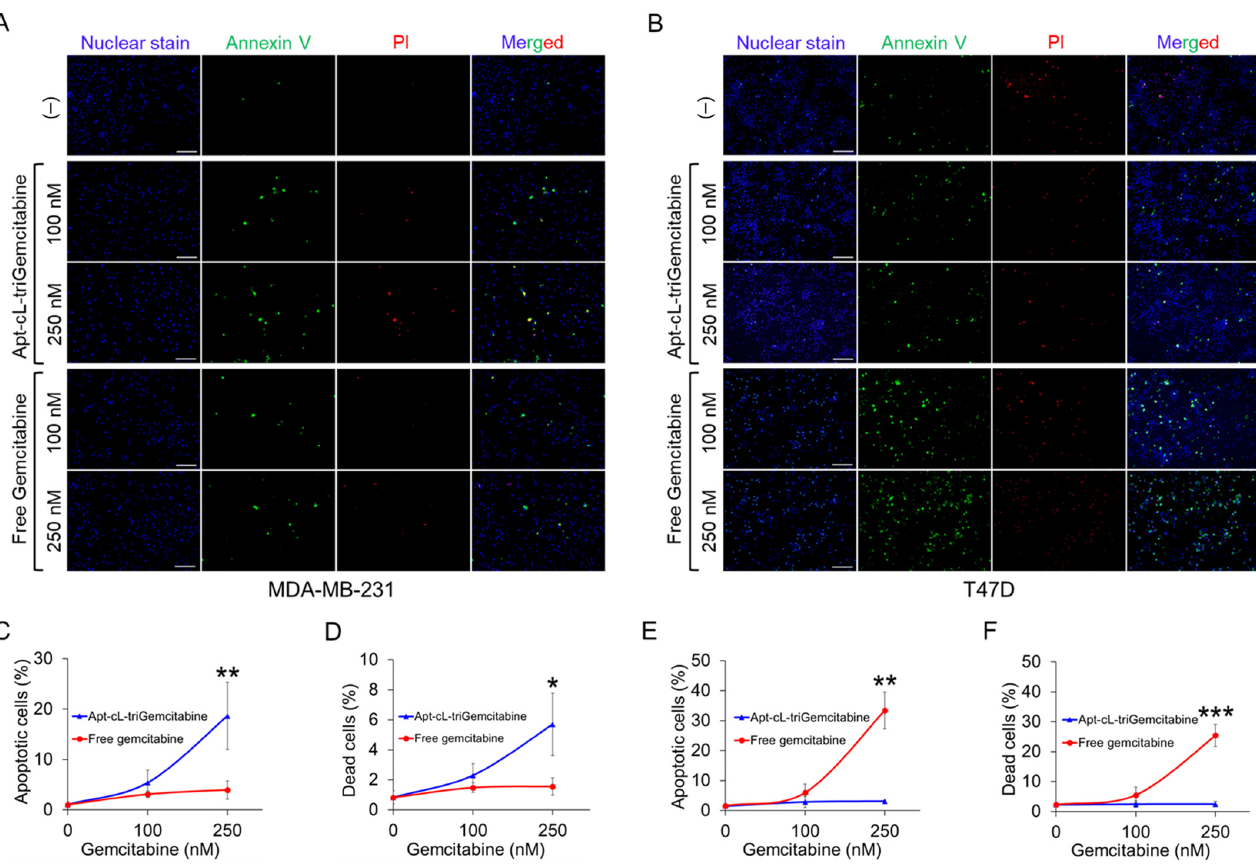
Figure 6. Apt–cL–triGemcitabine conjugate treatment induces apoptosis and death of targeted TNBC cells. Cultured tumor cells were treated as indicated for two days and stained with Annexin V (green fluorescence) to mark apoptotic cells, propidium iodide (PI) (red) to mark dead cells, and Hoechst dye (blue) for cell tracking purposes. ( A ) Fluorescent microscopic images of MDA-MB-231 cells (TNBC) treated with Apt–cL–triGemcitabine conjugate or free gemcitabine drug at equimolar amounts of gemcitabine, or no treatment as background baseline controls. ( B ) Fluorescent microscopic images of T47D (non-TNBC) cells with the same set of treatments. ( C , D ) Quantitative analysis of apoptosis and death rates in MDA-MB-231 cells post treatments as indicated. ( E , F ) Quantitative analysis of apoptosis and cell death rates of off-target T47D cells under the same treatment conditions. Scale bar = 200 µm. Significant differences between groups are indicated with asterisks. p ≤ 0.05 was considered significant. *: p ≤ 0.05; **: p ≤ 0.01; ***: p ≤ 0.001 (Student’s t-test).